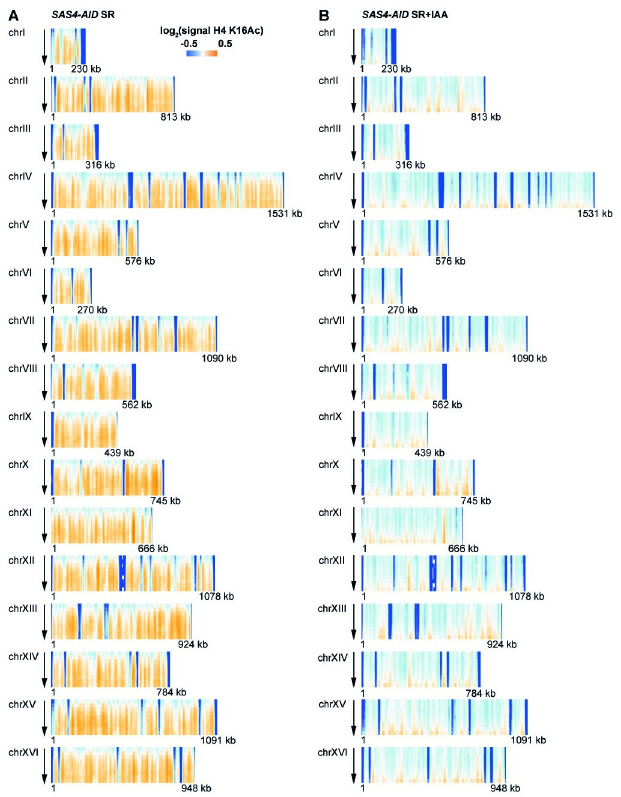
Fig 3. Genome-wide dynamics of H4 K16Ac during replication. H4 K16Ac levels during replication were measured in the presence (A, SR) and absence (B, SR+IAA) of Sas4. Data is represented as in Fig 2D.